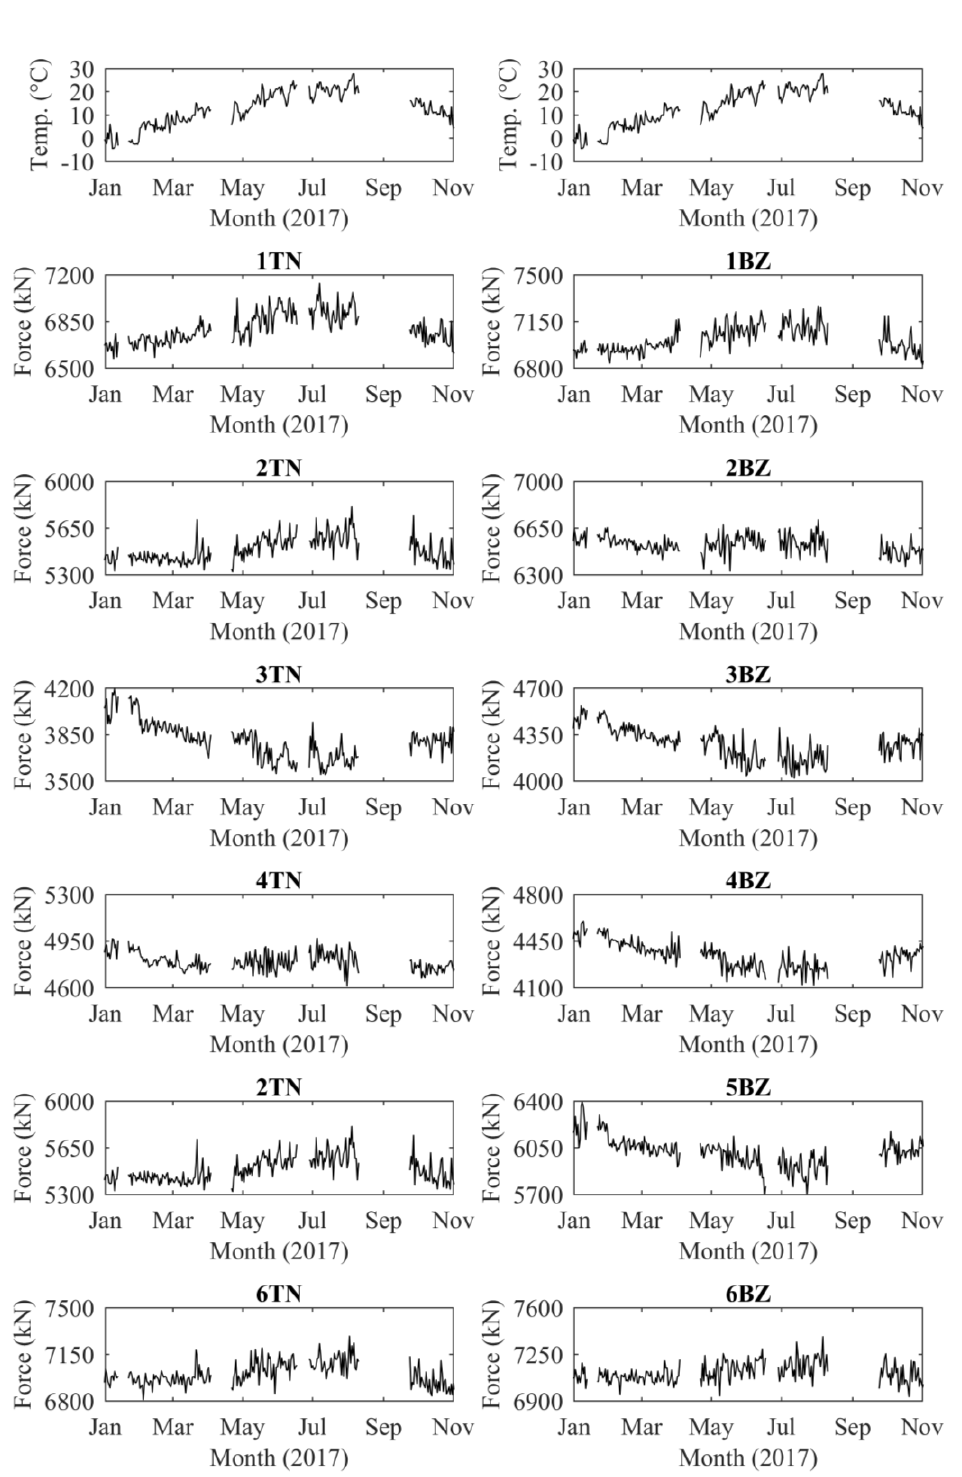
Figure 9. Calibrated monitoring data.